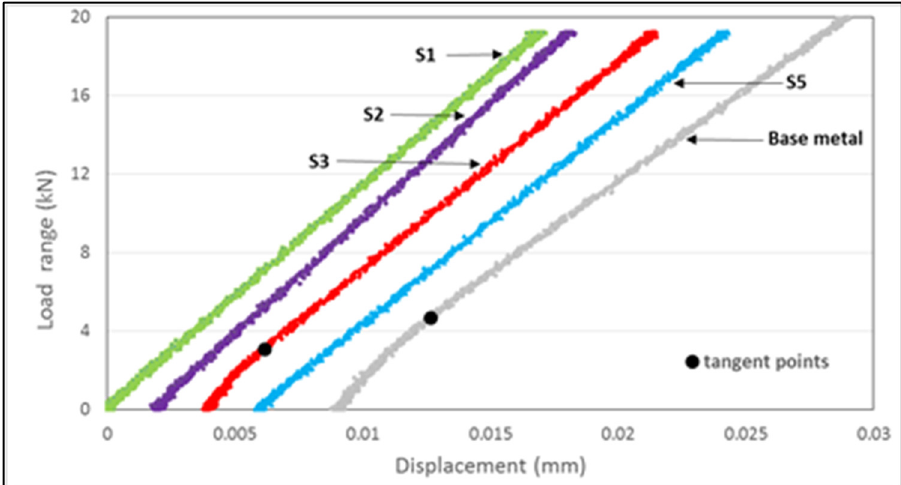
Figure 7. ∆ P-COD example curves of each welded series and BM.